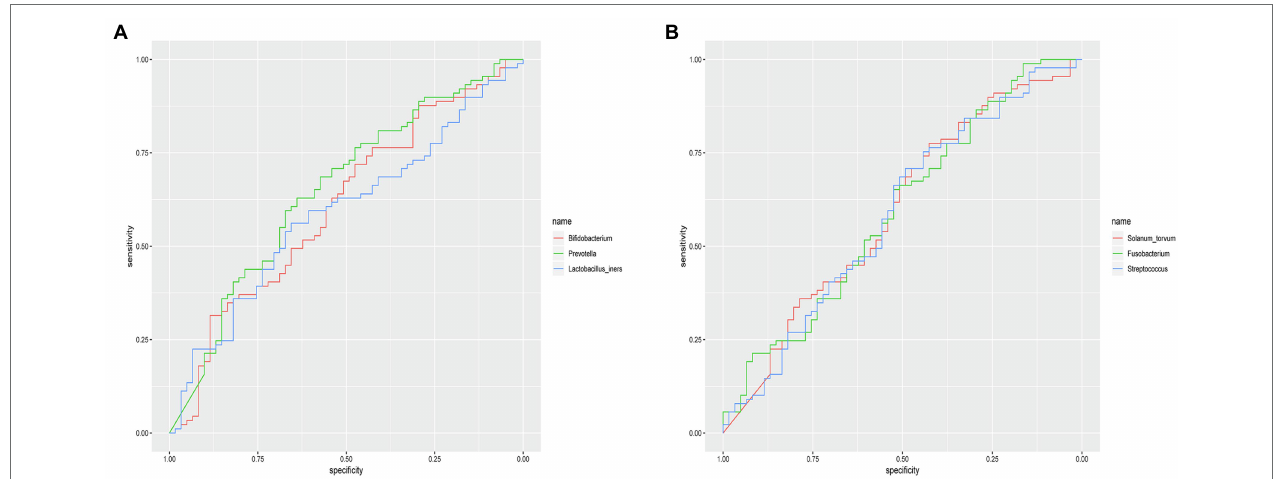
FIGURE 7 | ROC curves of specific genera for predicting non-pregnancy after IVF treatment. (A) ROC curves of Prevotella , Bifidobacterium , and Lactobacillus iners in the vagina for predicting non-pregnancy after IVF. (B) ROC curves of Solanum torvum , Fusobacterium , and Streptococcus in the cervix for predicting non-pregnancy after IVF.